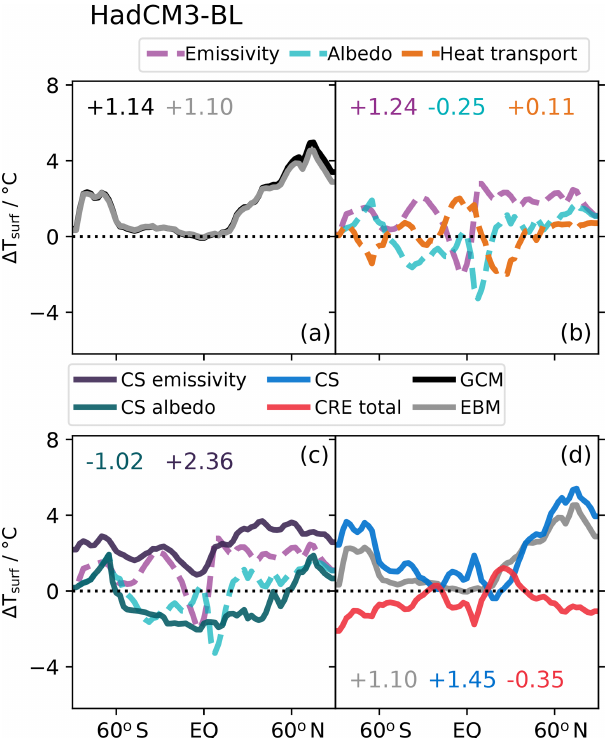
Figure 7. The 1-D EBM decomposition for PI-CM 35 sults (grey) vs. GCM results (black). (b) Decomposition of EBM into the emissivity (purple), albedo (green) and heat transport (or- ange) components of the temperature change. (c) Clear-sky emissiv- ity (dark purple) and clear-sky albedo (dark green) components of the EBM. The all-sky components are included for comparison. (d) Decomposition of EBM into the total clear-sky (blue), cloudy-sky (red) and all-sky (grey) components.